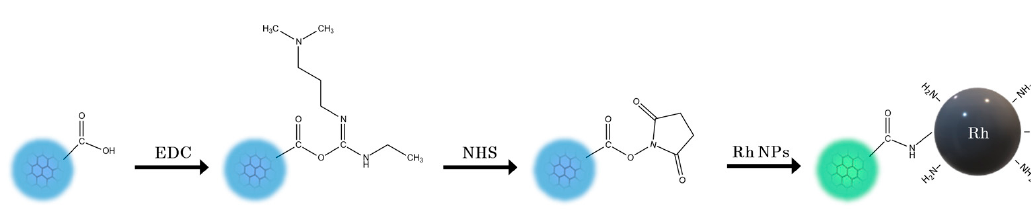
Figure 4. Conjugation scheme of Rh NPs with CQDs, leading to the green-emitting hybrid Rh-CQDs NPs.